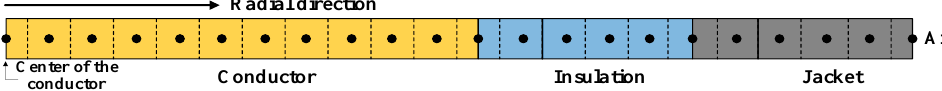
As explained, the temperature of an insulated cable depends on two main factors, which are the self-generated Joule ( I 2 r ) heating and the externally ambient temperature. Thus, in general, heat flows radially from the central part of the conductor to the outer part of the jacket. The whole domain of the cable is discretized into many discrete elements along the radial dimension of the cable, as shown in Figure 4.